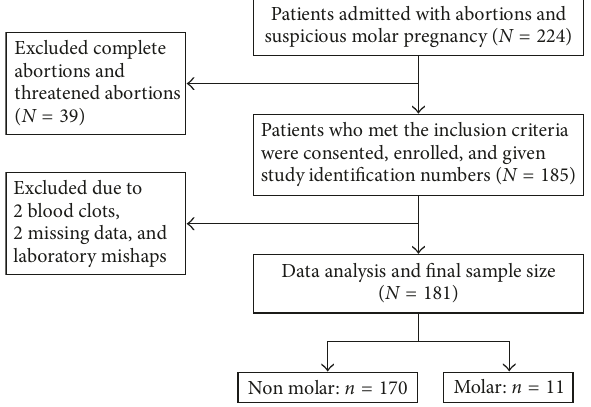
Figure 1: Flow diagram on